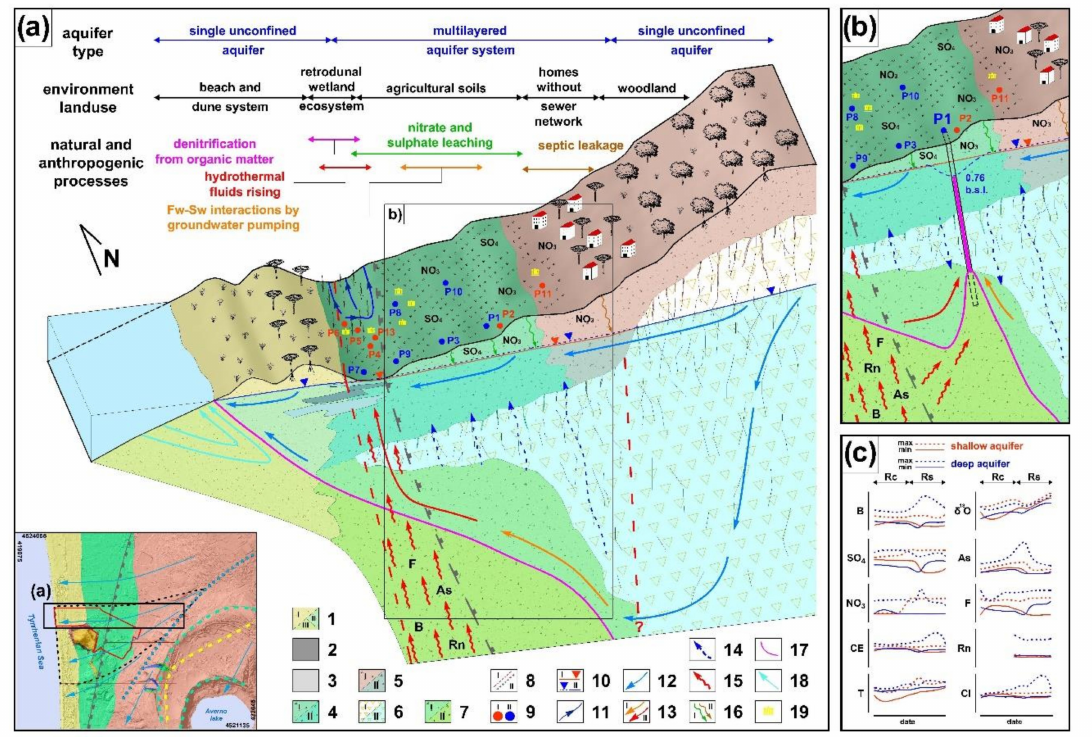
Figure 10. Hydrogeological–hydrogeochemical isotope conceptual model of study area, in natural conditions ( a ) and during pumping ( b ). ( c ) Trends of parameters showed in Figure 5, reporting maximum and minimum values of shallow (in red) and deep (in blue) wells with reference to the Rc and Rs periods. The blue and red arrows depict the groundwater flow paths within the aquifer system. The blue arrows indicate shallow groundwater and the red arrows indicate deeper and mineralized groundwater, which interact with the hydrothermal fluids upwelling along deep fractured zone of the CI caldera boundary. Legend: (1) unsaturated (i), freshwater saturated (ii) and saltwater saturated (iii) dune complex; (2) clays and peaty deposits; (3) silts; (4) unsaturated (i) and freshwater saturated (ii) PAP complex; (5) unsaturated (i) and freshwater saturated (ii) P complex; (6) unsaturated (i) and freshwater saturated (ii) YT aquitard; (7) freshwater saturated (i) and saltwater saturated (ii) DP complex; (8) buried normal fault (i) and CI caldera boundary (ii); (9) shallow (i) and deep (ii) wells; (10) piezometric level of phreatic shallow aquifer (i) and deep semiconfined aquifer (ii); (11) groundwater draining channel; (12) groundwater flow direction; (13) mineralized (i) and highly mineralized (ii) groundwater flow direction; (14) vertical groundwater flow direction; (15) high mineralized fluids rising; (16) sulfates and nitrates infiltration from agricultural lands (i) and urban areas (ii); (17) Fw-Sw interface; (18) saline groundwater flow; (19) archaeological site of Monumental Roman